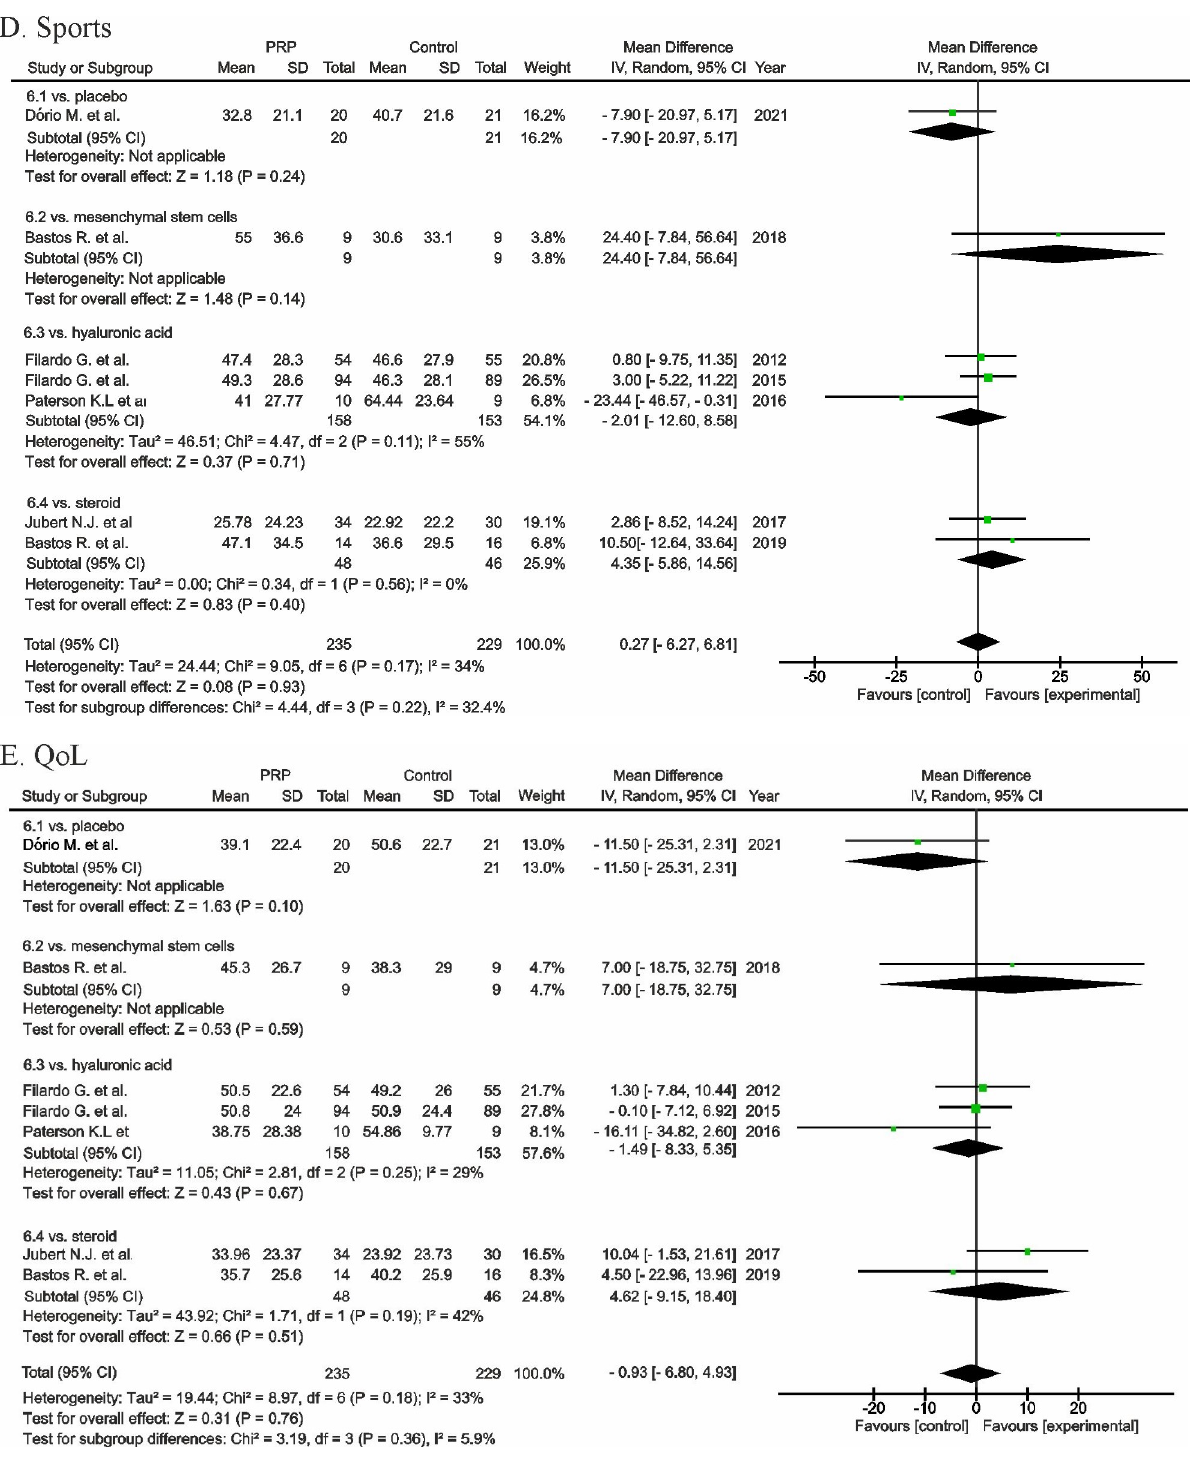
Figure 6. Forest plot for KOOS sub-scores (ADL, activities of daily living; CI, confidence interval; IV, inverse variance; QoL, quality of life; SD, standard deviation; , mean with 95% confidence interval for total and subtotals; , mean with 95% confidence interval for source data).